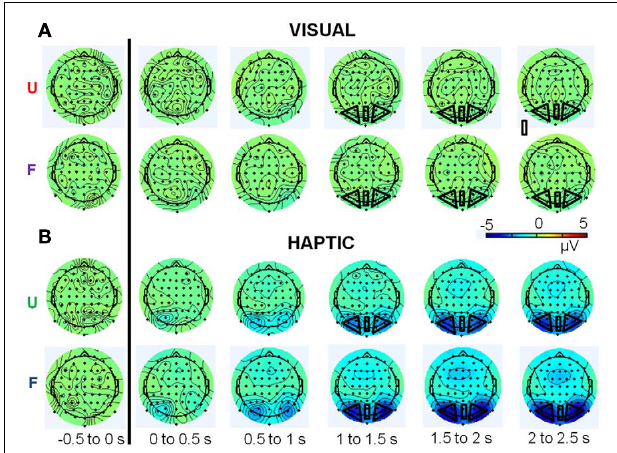
FIGURE 6 |Topographical plots of total upper alpha-band (10–12Hz) activity for the (A) visual and (B) haptic object recognition tasks. Plots are displayed in 500ms time segments, from − 500 to 2500ms, with the black line indicating stimulus onset. “U” stands for unfamiliar and “F” for familiar objects. Note: same scale for vision and haptics.